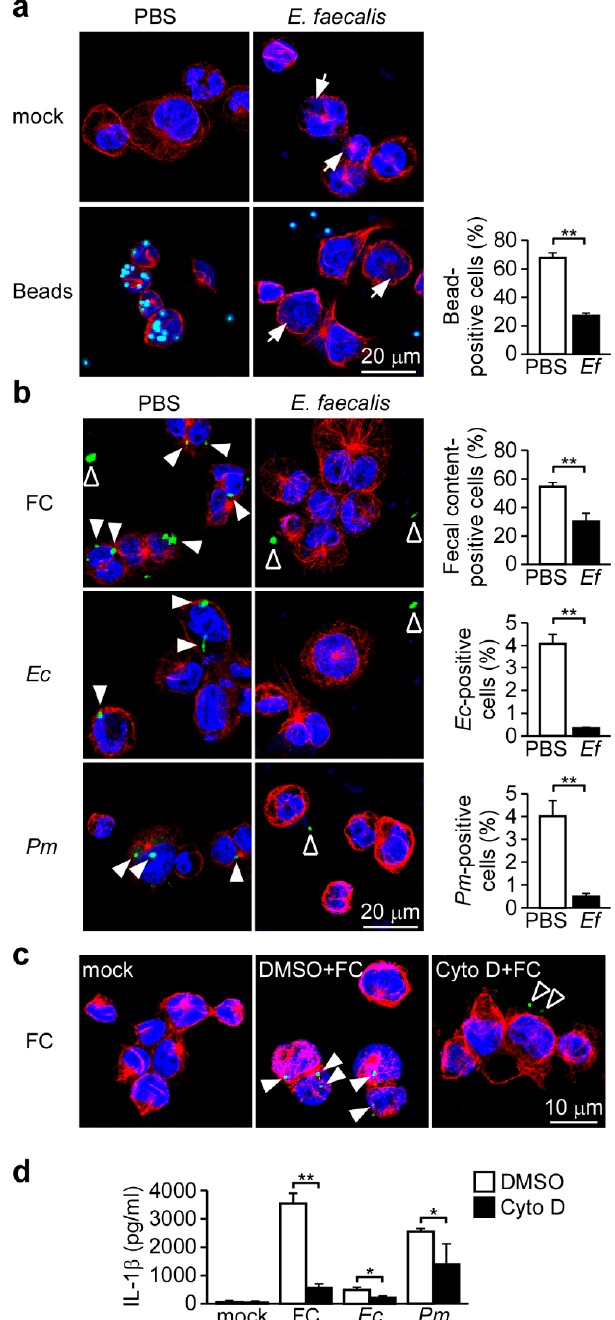
Figure 3. Phagocytosis, which is required for bacteria-induced inflammasome activation, is inhibited by E. faecalis. ( a , b ) THP-1-derived macrophages were pretreated with E. faecalis (Ef, 2 mg/mL) for 24 hours, incubated for 3 h with ( a ) beads, ( b ) FC, Ec or Pm, and assessed for phagocytosis . Scale bars, 20 μ m. Phagocytosis was quantified with an IN Cell Analyzer. ( c ) Assessment of phagocytosis in THP-1-derived macrophages pretreated with cytochalasin D for 1 h and then incubated for 3 h with FC. Scale bars, 10 μ m. Cells were stained for visualization of tubulin (anti- α -tubulin, red), beads, FC, Ec or Pm (CFSE, green) and nuclei (DAPI, blue). ( d ) ELISA of IL-1 β in the SN of THP-1-derived macrophages pretreated with cytochalasin D for 1 h and then infected for 3 h with FC, Ec or Pm. *, p < 0.05; and **, p < 0.01. Arrow, phagocytosed E. faecalis . Closed arrowhead, phagocytosed FC, Ec or Pm . Open arrowhead, unphagocytosed FC, Ec or Pm . These data are representative of three independent